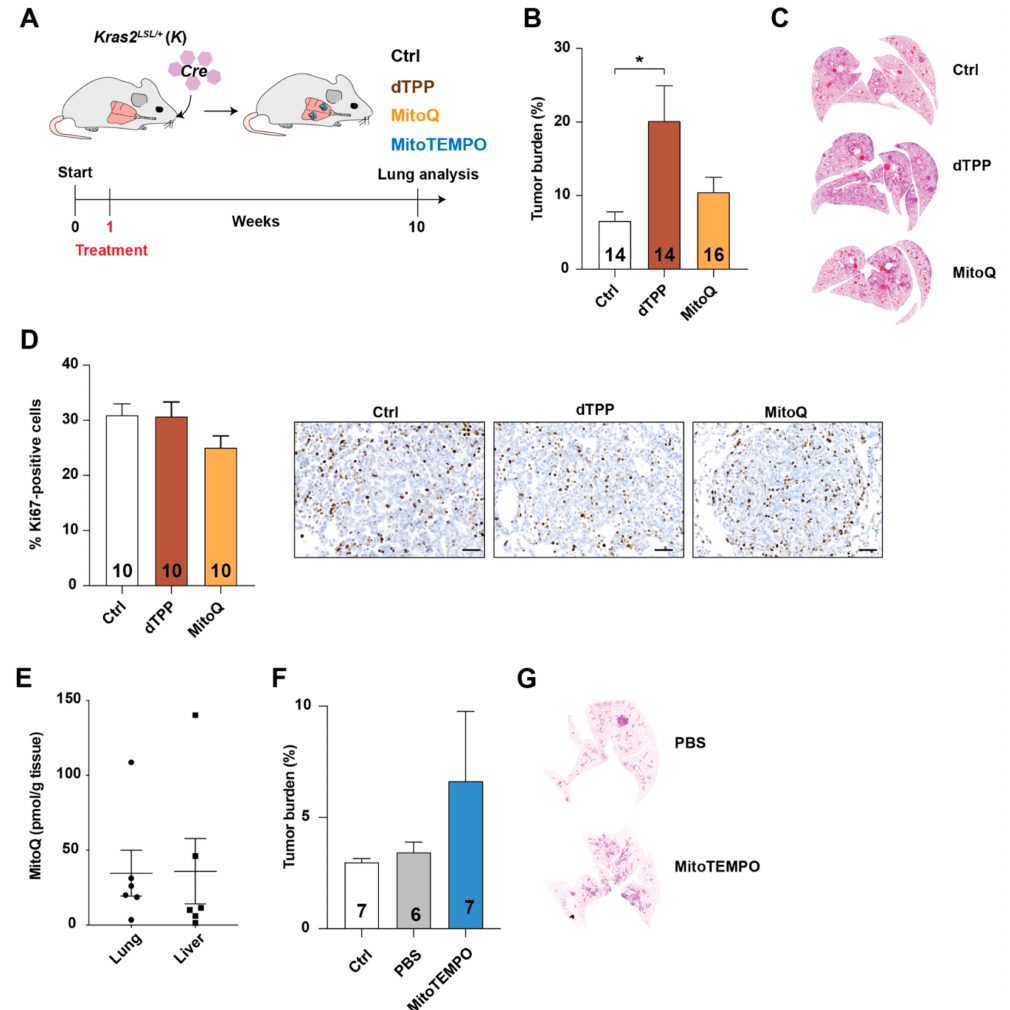
Figure 3. MitoQ and MitoTEMPO does not influence tumor growth in mice with lung cancer. ( A ) Schematic showing how a Cre -adenovirus given intranasally to 6–8-week-old Kras2 LSL/+ mice activated KRAS G12D expression in the lung (start). One week later, mice were given regular water (Ctrl) or water supplemented with MitoQ (500 µ M) or dTPP (500 µ M); in separate experiments, mice were left untreated or injected i.p. with MitoTEMPO (1.25 mg/kg) or PBS. ( B ) Tumor burden (percent tumor area per lung area) in lungs from Ctrl, dTPP-treated, and MitoQ–treated Kras2 LSL/+ mice, 10 weeks after inhalation of Cre -adenovirus. ( C ) Representative hematoxylin and eosin–stained lung sections from mice in panel B. ( D ) Proliferation index (percent Ki67-positive cells). Right panels, representative photographs of Ki67-stained lung sections. ( E ) Mass spectrometry–based detection of MitoQ in lung and liver samples of tumor-bearing Kras2 LSL/+ mice administered MitoQ in the drinking water for 10 weeks, as described in panels A and B. ( F ) Tumor burden (percent tumor area per lung area) in lungs from Ctrl and PBS- and MitoTEMPO-injected Kras2 LSL/+ mice, 10 weeks after inhalation of Cre -adenovirus. ( G ) Representative hematoxylin and eosin–stained lung sections from mice in panel F. Numbers in bars = n . Scale bar = 50 µ m. * p <